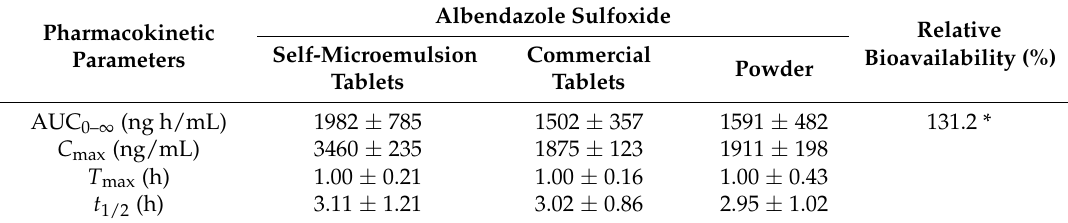
Figure 9. Mean plasma concentration/time profiles of albendazole sulfoxide after oral administration of albendazole at a dose of 50 mg/kg in SMEDDS chewable tablets formulation F2 (solid circles, n = 5), albendazole commercial tablets (open circles, n = 5) and albendazole powder (solid triangles, n = 5) in rats. Data shown indicate mean ± standard deviation (SD). Table 6. Comparative mean (SD) of pharmacokinetic parameters of albendazole sulfoxide in rats after oral